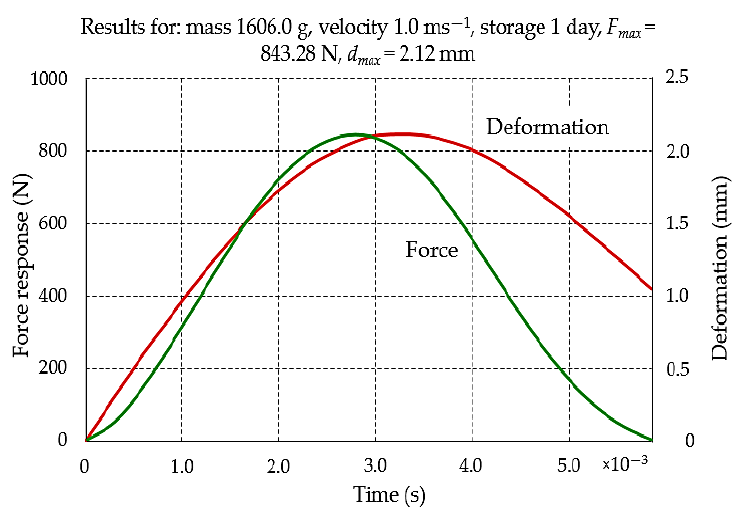
Figure 6. Typical force response in time and deformation in time curves during the impact of sugar beet root against the rigid plate.